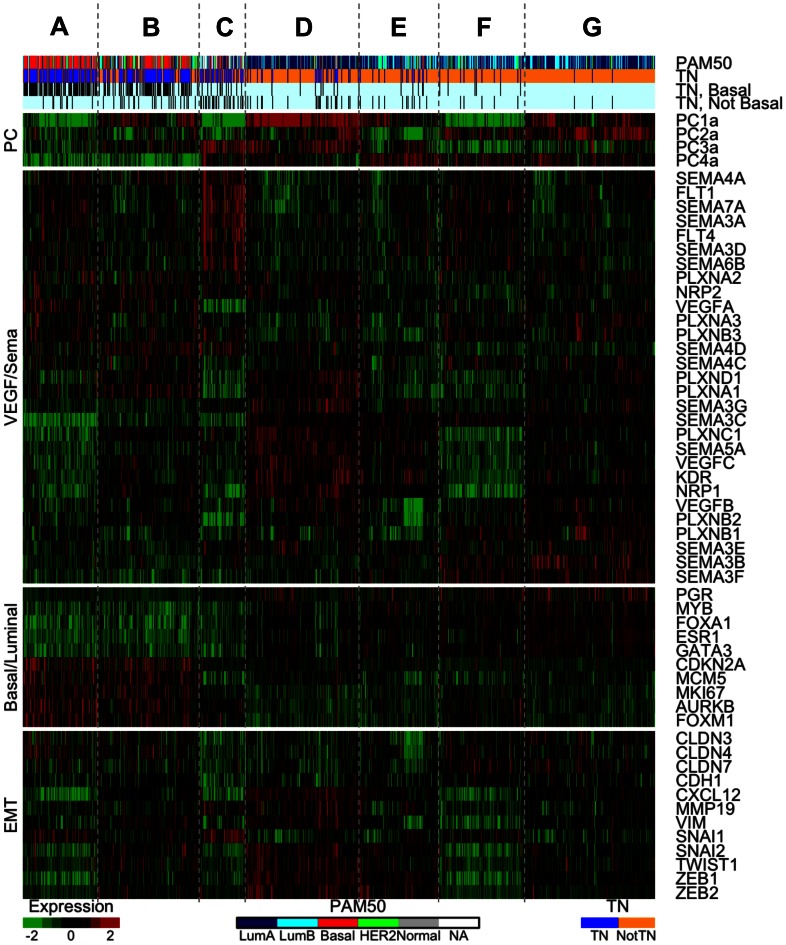
Heatmap of the 7 VEGF/Sema-based tumor clusters.Samples are ordered across the columns by cluster membership as determined by consensus K-means clustering. The clusters are ordered by TN content, with cluster A on the left having the highest percentage of TNBCs. The VEGF/Sema-based clusters are able to differentiate the basal intrinsic subtype from the other intrinsic (PAM50) subtypes. As previously noted, the basal subtype is strongly associated with triple negative tumors (third and fourth bars: black for basal TNBCs and non-basal TNBCs, respectively). Other breast cancer-related genes have expression patterns that align with the VEGF/Sema-based clusters.